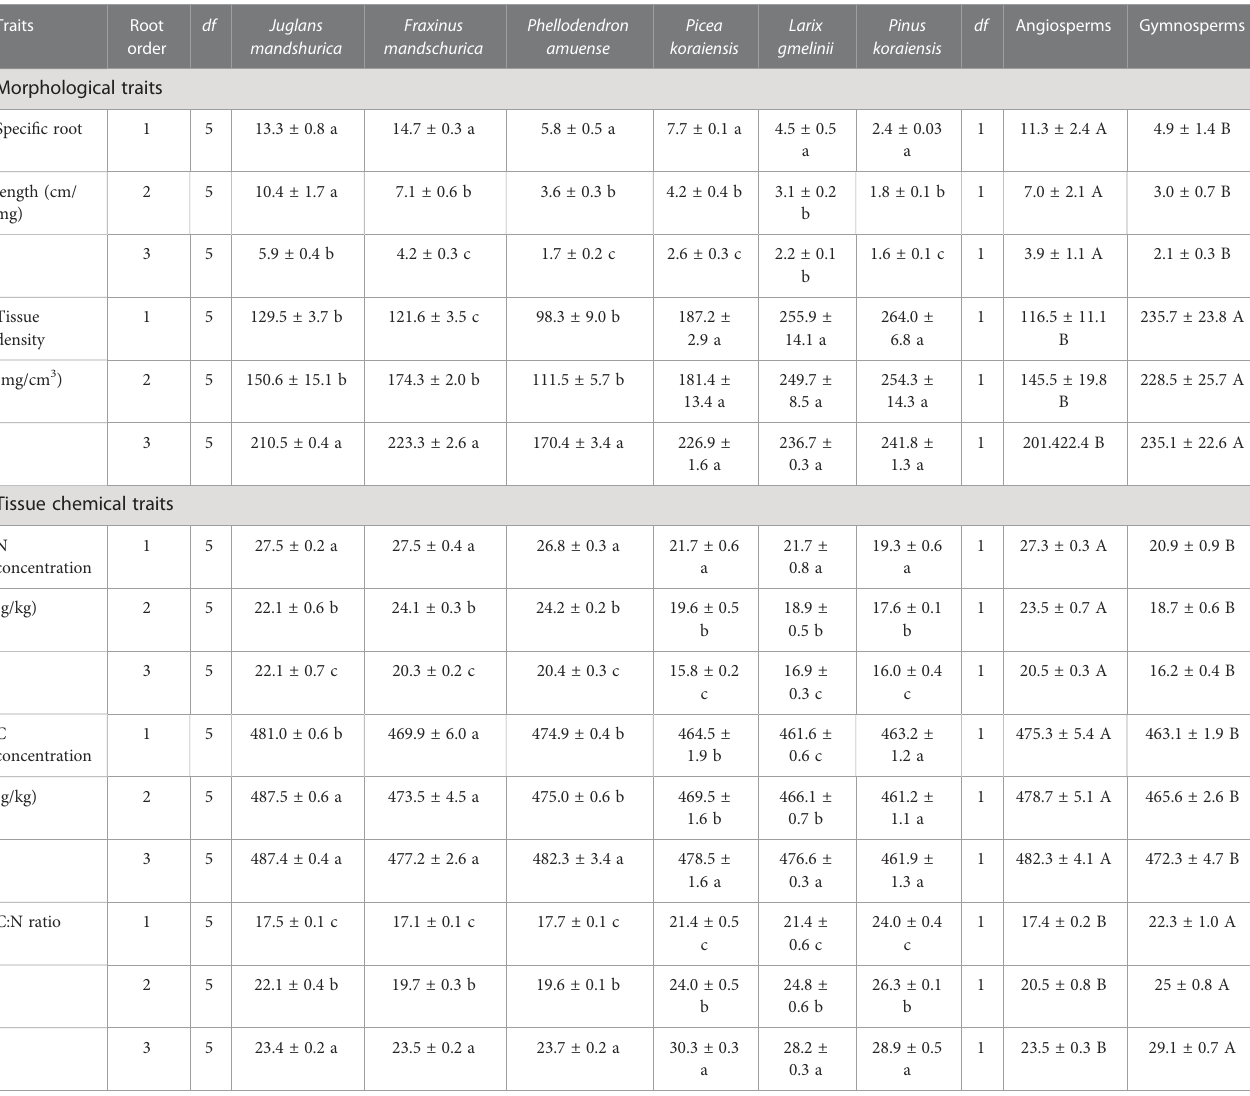
TABLE 3 The mean and standard error of morphological and tissue chemical traits for the fi rst three absorptive root orders in three angiosperms and three gymnosperms tree species ( n = 6).